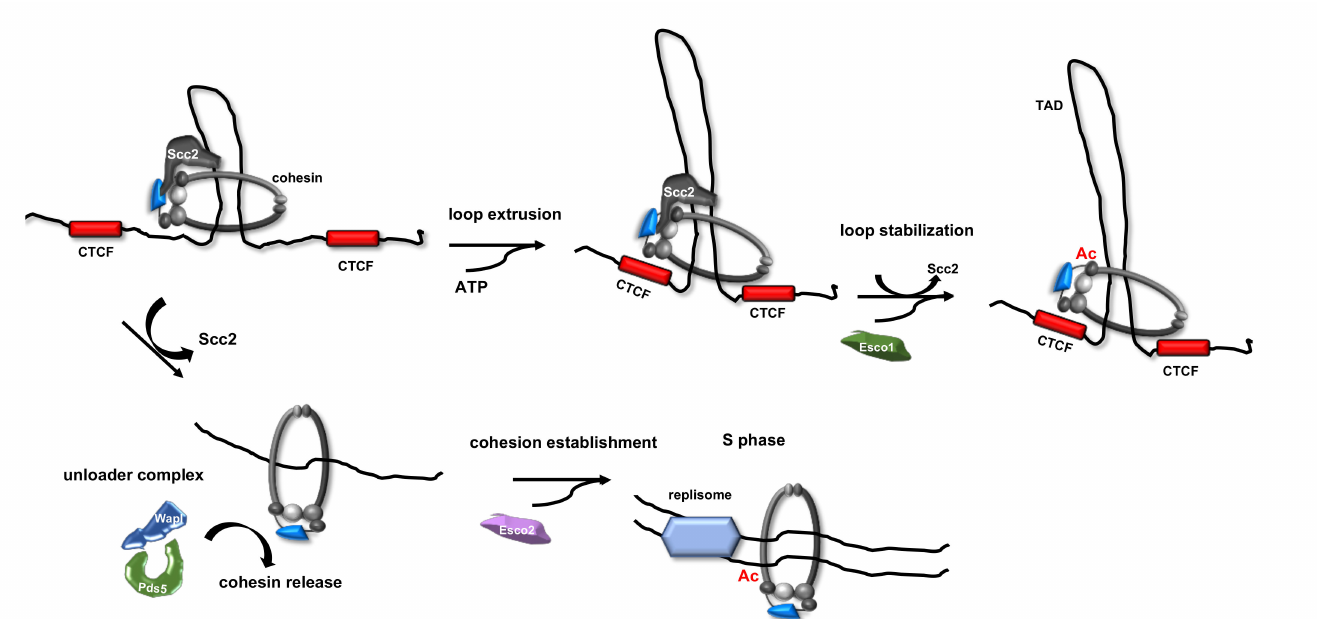
Figure 3. Regulation of cohesin functions by Esco1 or Esco2 acetyltransferases. Cohesin loading onto chromatin and loop extrusion activity both depend on association with Scc2 factor. Formation of chromatin topologically associating domains (TADs) in interphase cells is due to the loop extrusion activity of the cohesin-Scc2 complex. TAD boundaries are defined by the CCCTC-binding factor (CTCF), a sequence specific DNA binding protein that acts as a chromatin insulator [28]. The activity of Esco1 during interphase, before DNA replication starts, stabilizes TADs to define chromatin spatial organization. Conversely, Esco2 activity during S phase ensures that replicated sister chromatids are stably entrapped within the cohesin rings. Mode of DNA binding of cohesin-Scc2 complex is only